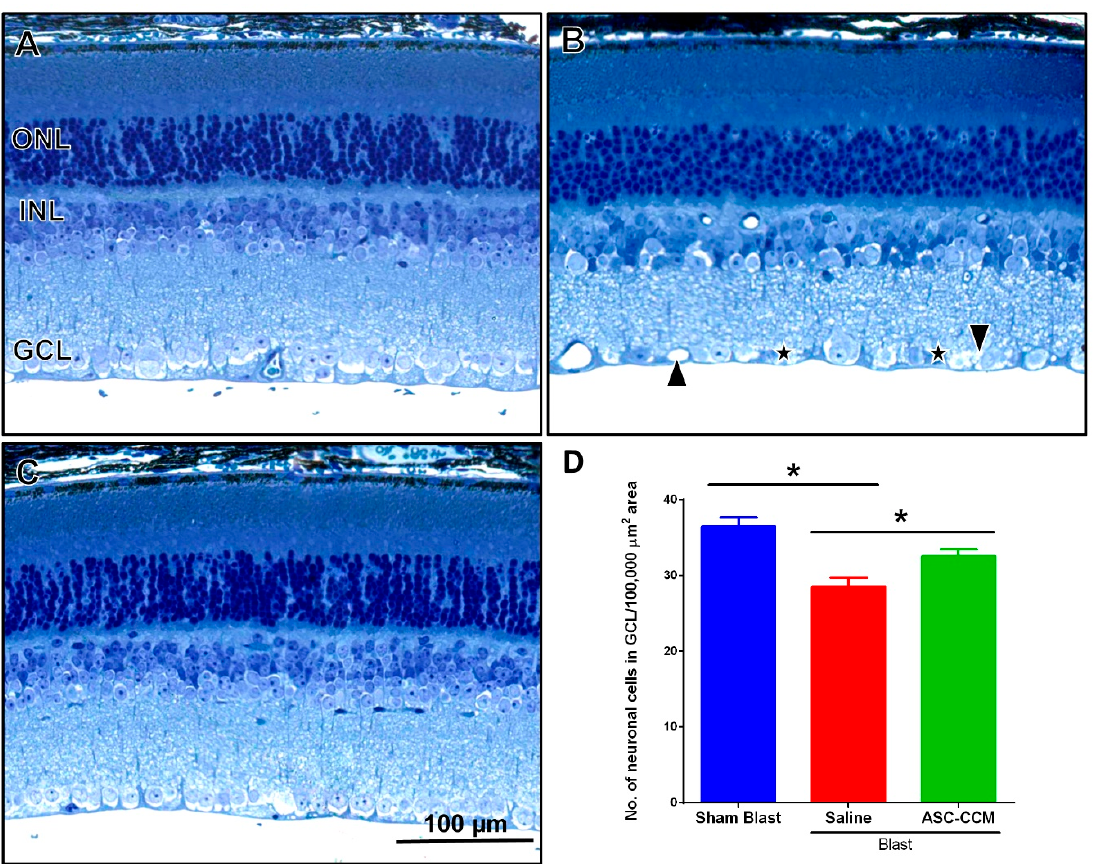
Figure 4. ASC-CCM reduces morphological changes in the retina in blast injury mice. ( A ) Toluidine blue stained sections of retina from the sham group. ( B ) Focal loss of neuronal cells (star) and many vacuolated spaces (arrowheads) in the ganglion cell layer (GCL) were prominent in the blast group. ( C ) Improved morphological appearance observed with ASC-CCM. ( D ) Quantification of mean number of neuronal cells/100,000 μ m 2 area. Data represent Mean ± SEM from n = 3 animals/group. *, p < 0.05. Scale bar = 100 μ m.